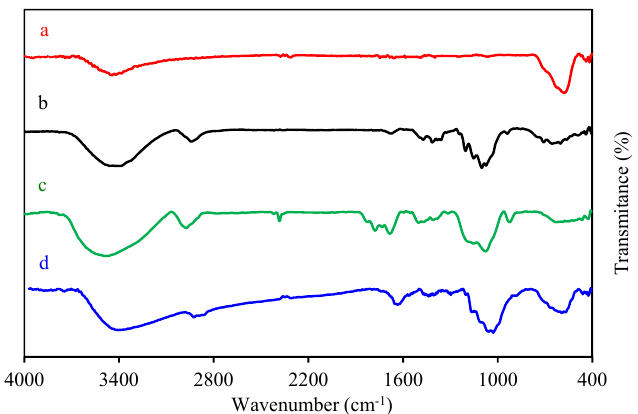
Fig. 4: FT-IR spectra of Fe